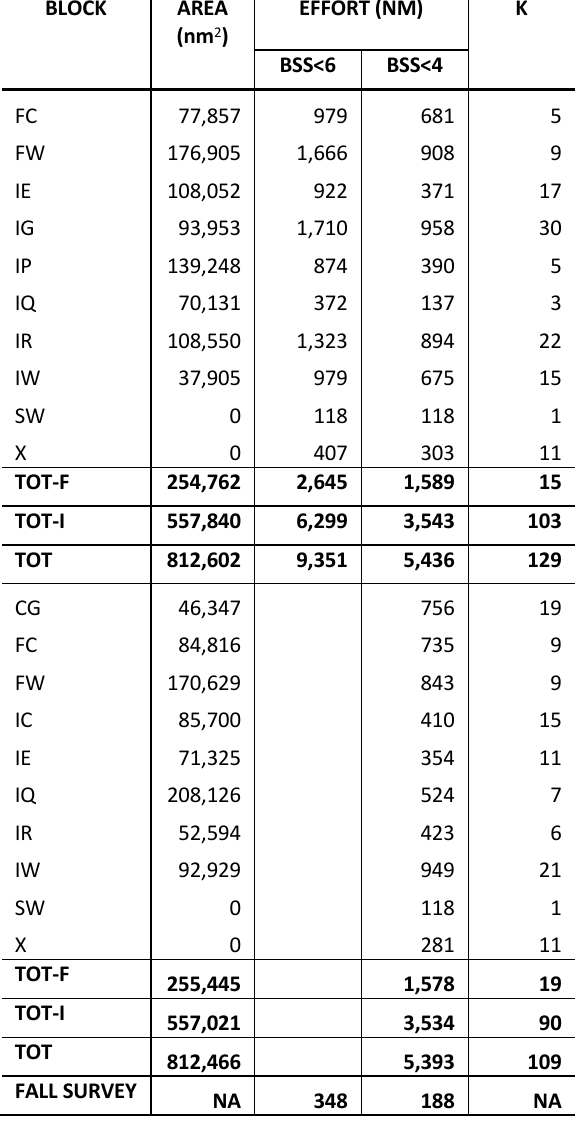
Table 1. Stratification and survey effort at 2 levels of Beaufort sea state (BSS) for the base stratification (above) and minke whale post- stratification (below). K = number of transects. Block SW is effort outside the survey area, and block X is transit effort within other strata that is not used to estimate encounter rate. Effort is also shown for the fall survey. TOT-F and TOT-I: Tptal effort of the Faroese (H) and Icelandic (A and B) vessels,